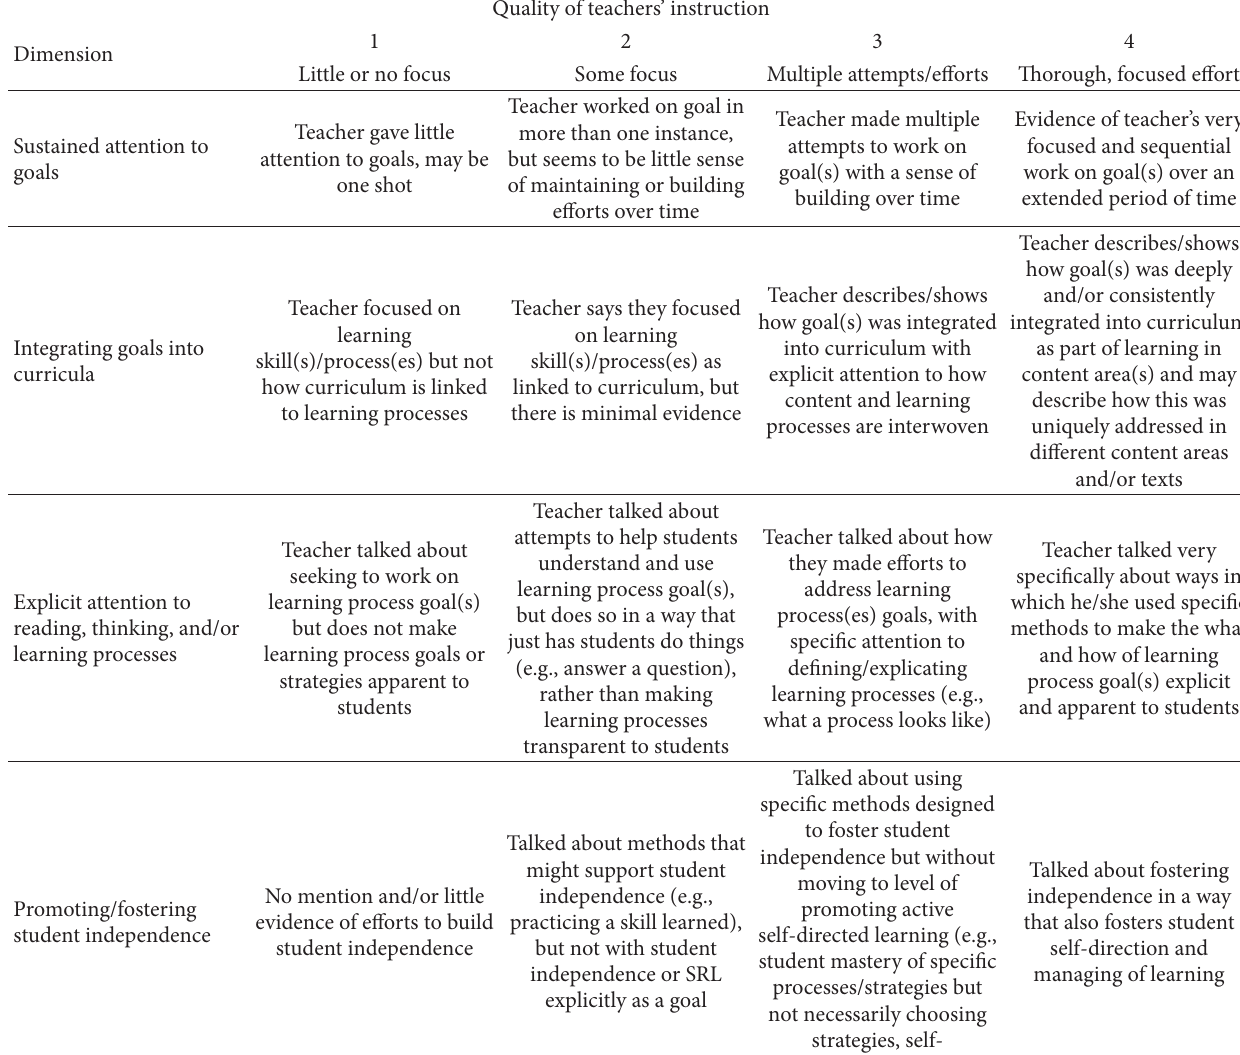
T 4: Coding criteria for instructional qualities evident in teaching practices as represented in interviews and